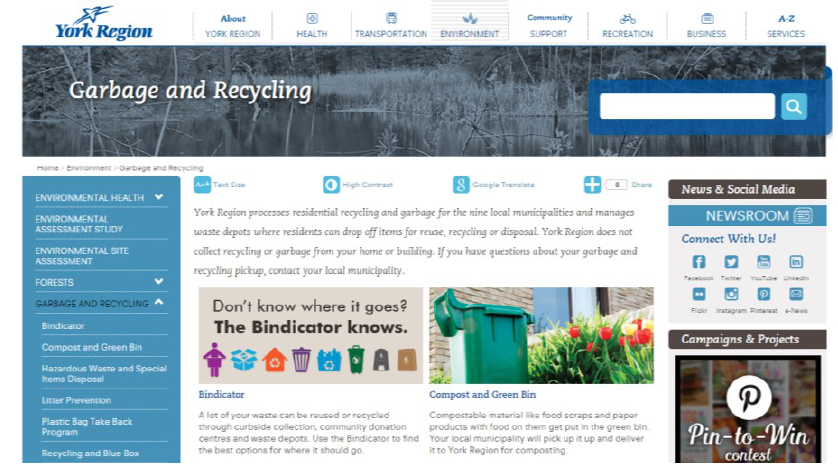
Figure 15. Sample Web Page #2 (York Region).